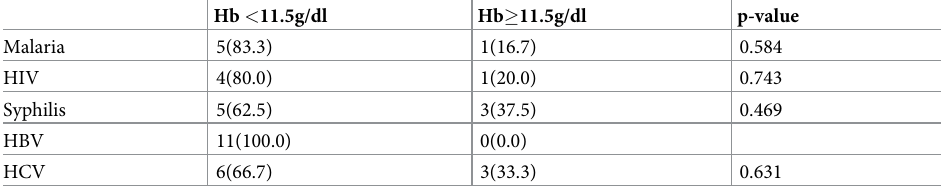
Data is presented as frequencies with percentages of the respective parameters in parenthesis and the significant level at